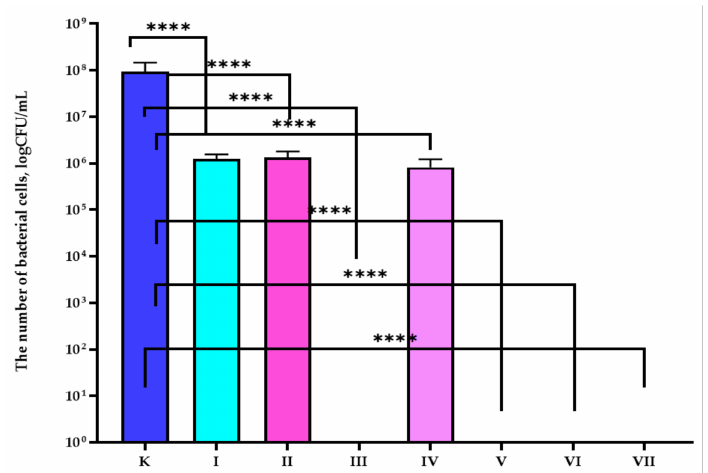
Figure 1. The influence of coated, active films on S . aureus growth. One-way ANOVA test: ****— p <